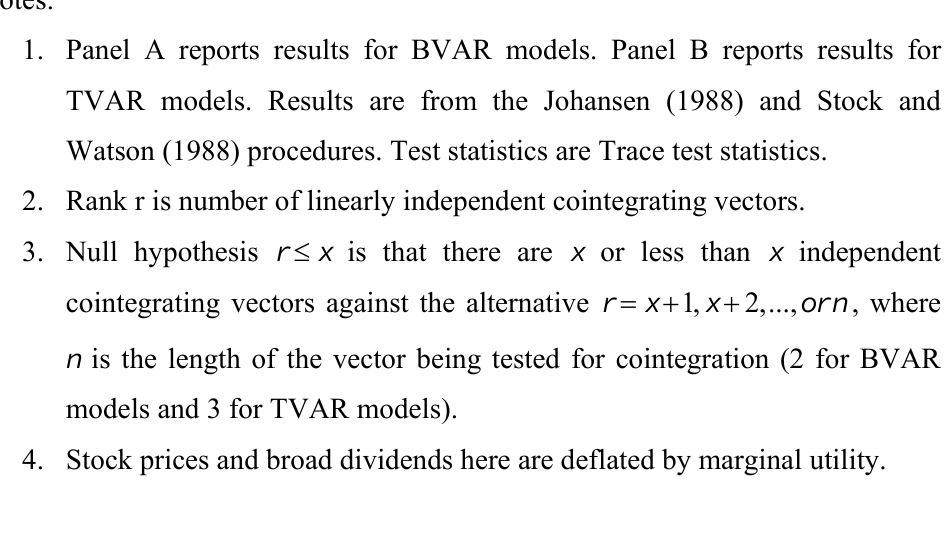
Table 6 Cointegration Tests for S&P (with consumption data) Panel